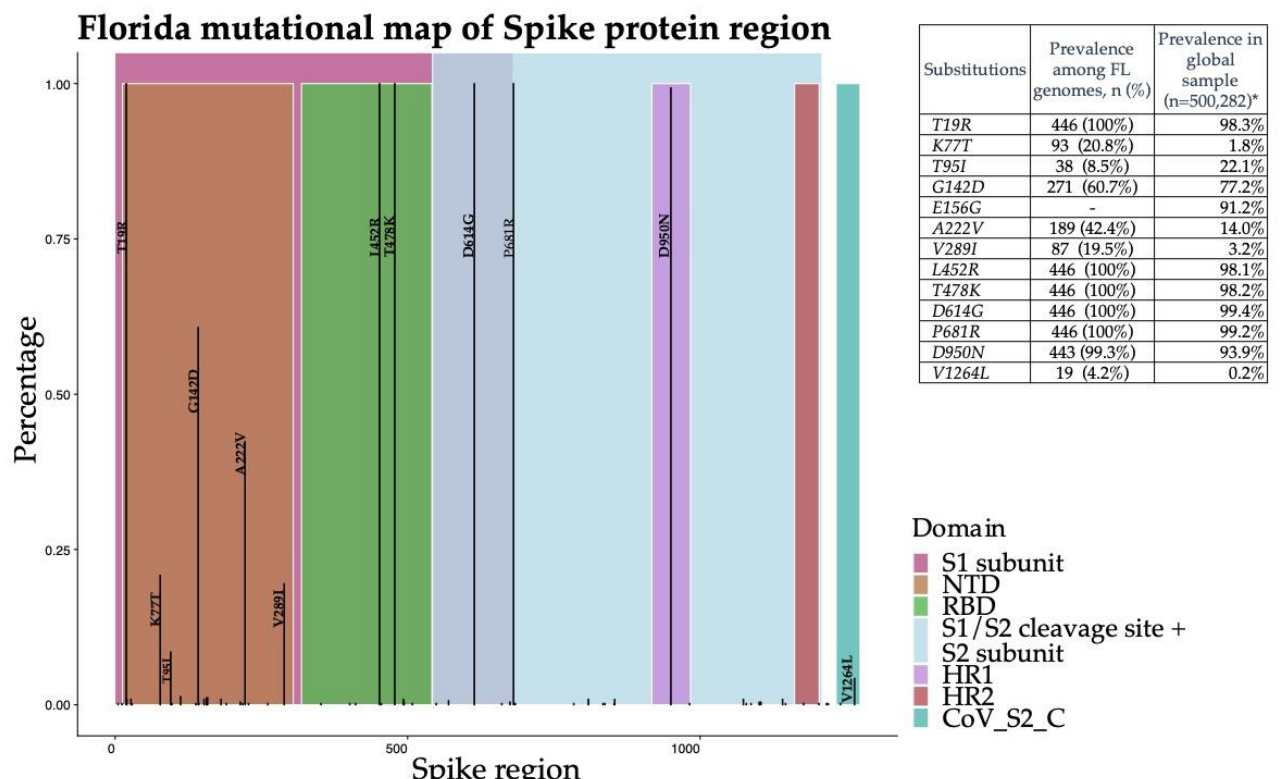
Figure 2. Distribution of spike protein substitutions among Florida SARS-CoV-2 Delta (B.1.617.2) variant genomes. The x-axis shows the coordinates of the region encoding the spike protein and the y-axis shows the proportion of genomes carrying the substitution. Substitutions with a prevalence greater than 2% are annotated. The inlaid table includes the Delta variant characterizing substitutions in spike protein region, the prevalence among Florida genomes, and the prevalence among worldwide Delta genomes sampled from GISAID (*) (https://outbreak.info/compare-lineages?pango=B.1.617.2&gene=S&threshold=0.2 (accessed on 13 July 2021)).